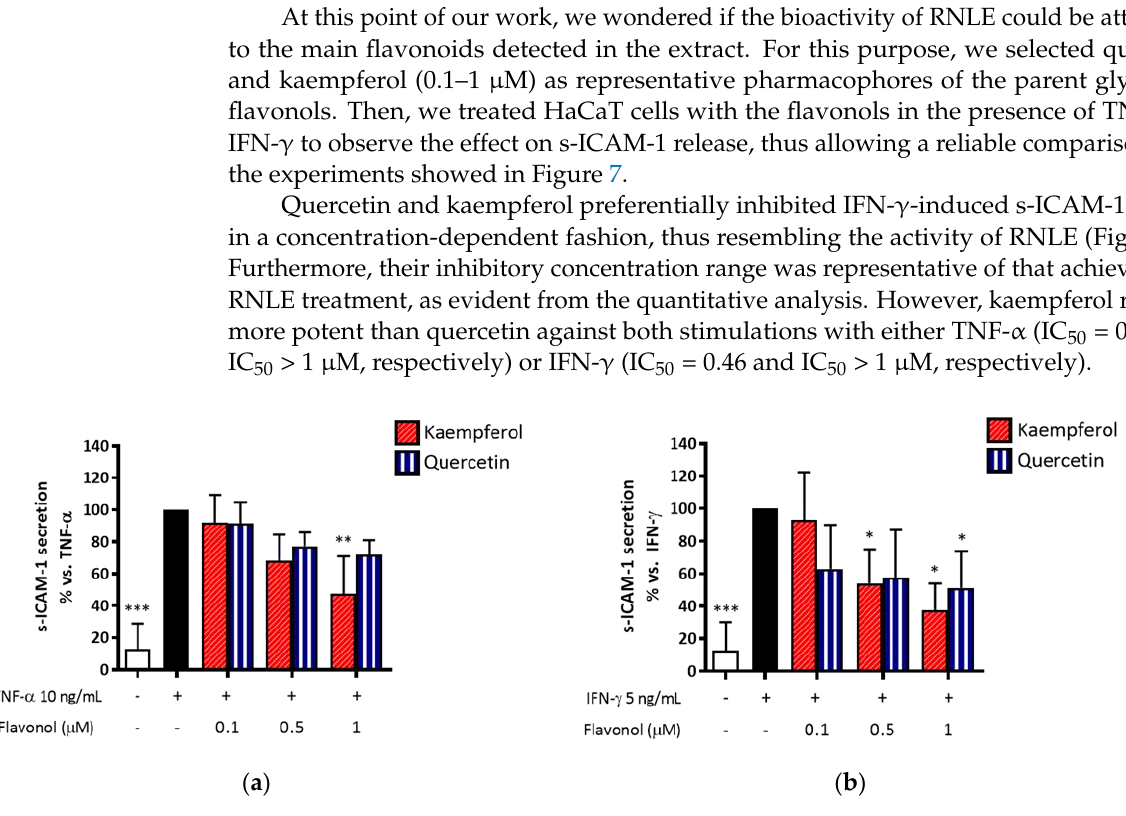
TNF- α (10 ng/mL, 24 h). ( b ) Effect of quercetin and kaempferol treatment (0.1–1 µ M) on s-ICAM-1 release in HaCaT cells